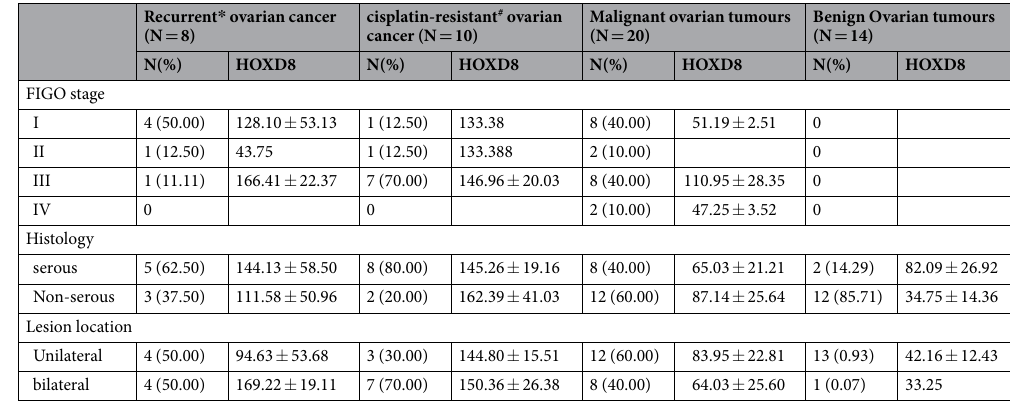
Table 2. The clinicopathological characteristics and expresion of HOXD8 in patients with different ovarian diseases (N = 52). * The patients with recurrent ovarian cancer, the median disease-free survival was 20.4 months, range from 12–24 months and the median overall survival was 36.4 months, range from 24–62 months). # The patients with cisplatin-resistant ovarian cancer, the median progression free survival was 4.2 month, range from 3–5 months and the median overall survival was 12 months, range from 9–28 months.